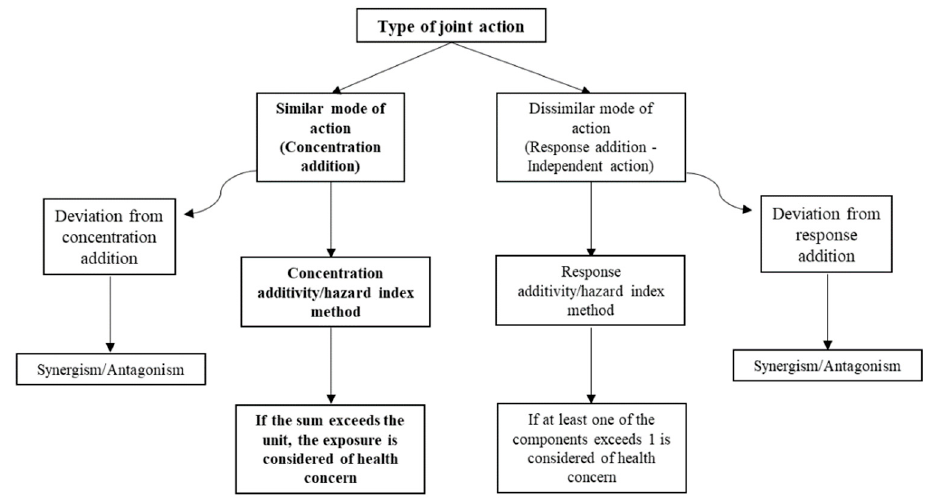
Figure 1. Flowchart representing the types of joint action (similar and dissimilar) and the respective applicable methods in mixtures risk assessment.